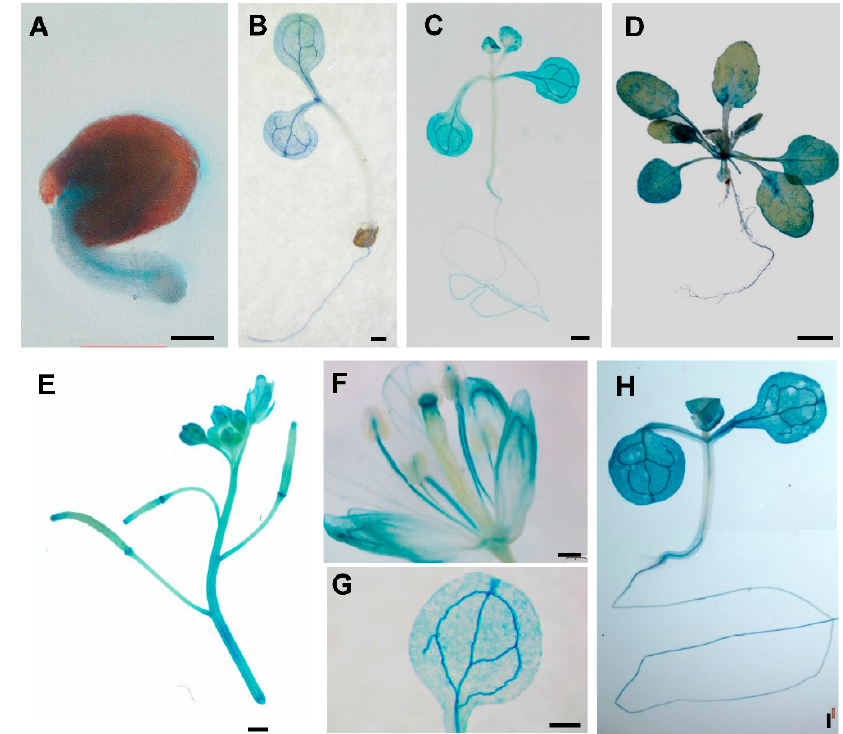
Figure 3. Spatiotemporal characterization of PtSAP13 in p PtSAP13::GUS transgenic Arabidopsis . ( A ) 1-day-old seedling; ( B ) 3-day-old seedling; ( C ) 10-day-old seedling; ( D ) 1-month-old seedling; ( E , F ) flower; and ( G ) leaf. ( H ) The GUS staining of a 10-day-old seedling of p PtSAP13::GUS was treated with salt. Scale bars: ( A ) 500 μ m; ( B – D ) 1 mm; ( E ) 5 mm; ( F ) 1 mm; ( G ) 250 μ m; and ( H ) 1 mm.